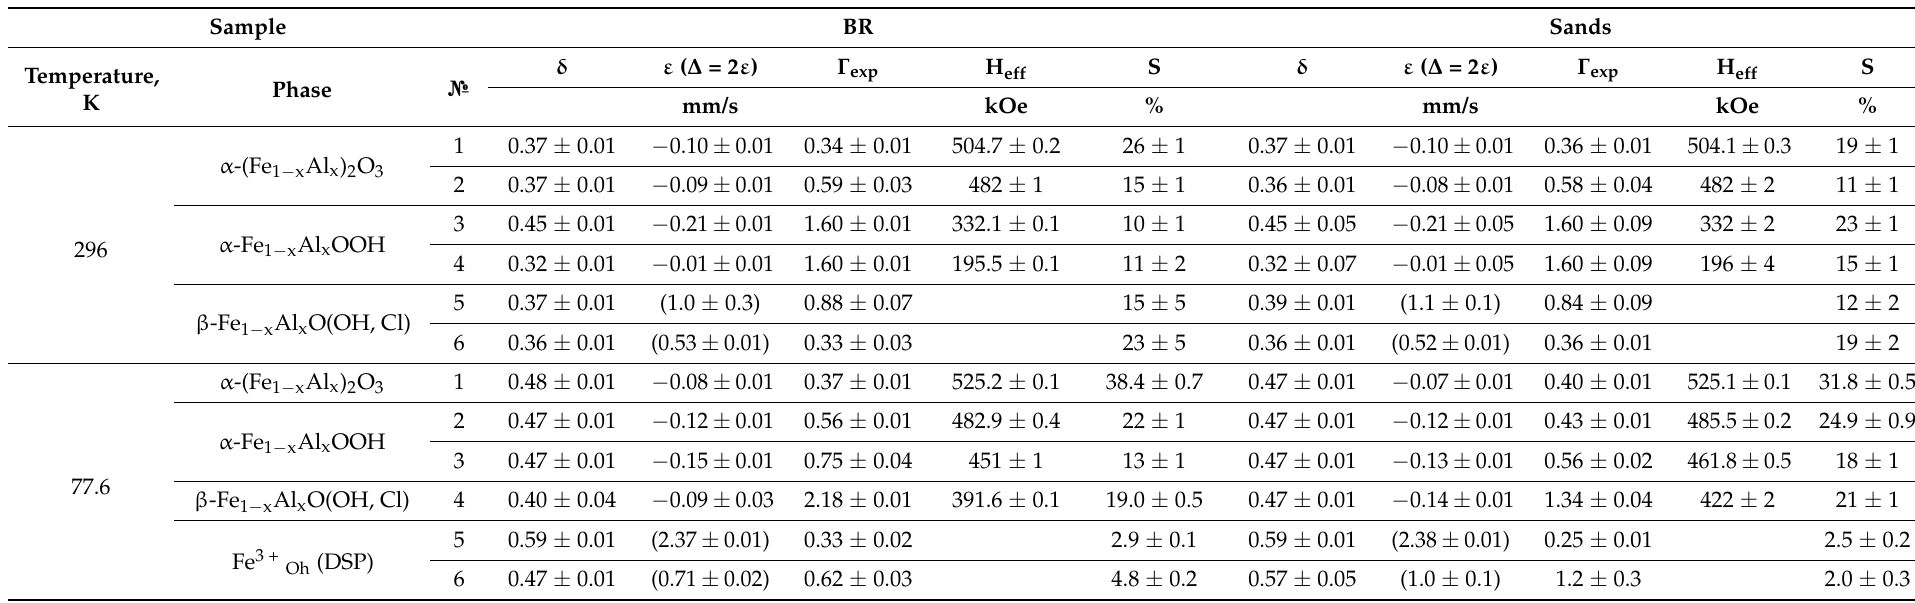
Table 2. The subspectrum parameters describing the experimental Mössbauer spectra obtained at varying temperatures for BR and sand